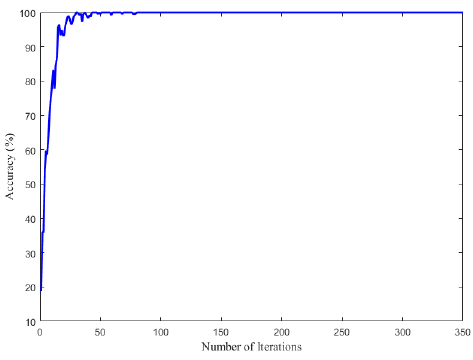
Figure 8. Depiction of the accuracy of model.